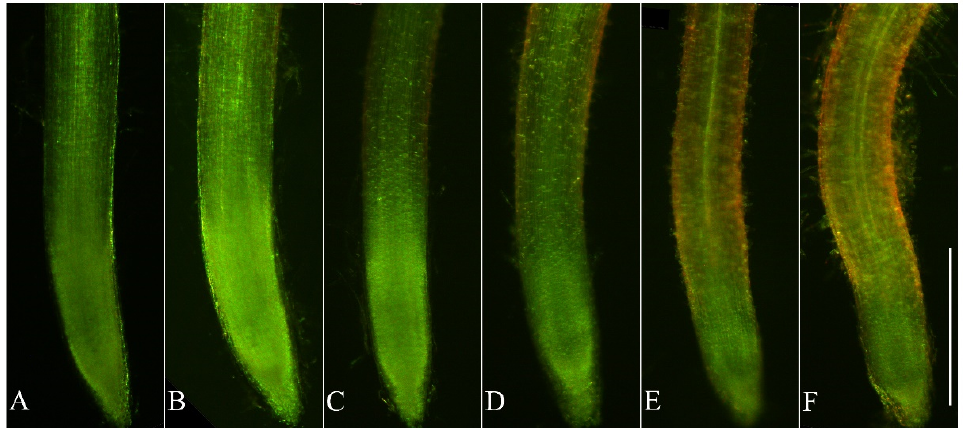
Figure 4. Cell viability in lettuce root tips after treatments with acacetin. Lettuce seedlings were treated with acacetin at concentrations of ( A ) 0, ( B ) 1, ( C ) 10, ( D ) 50, ( E ) 100 and ( F ) 500 μ M for 48 h. Roots were stained with FDA/PI. Green fluorescence and red fluorescence indicate viable and dead cells in root tips, respectively. Bar = 500 μ m.